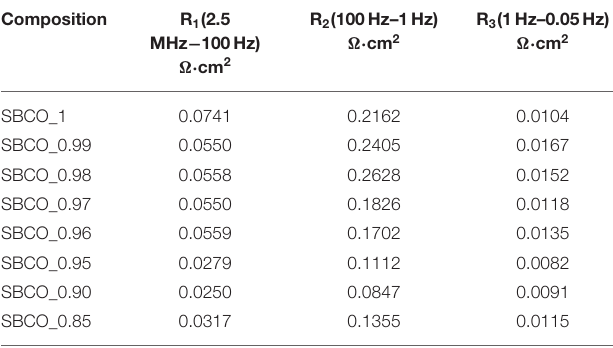
TABLE 2 | ASR results of symmetrical half cells comprised of